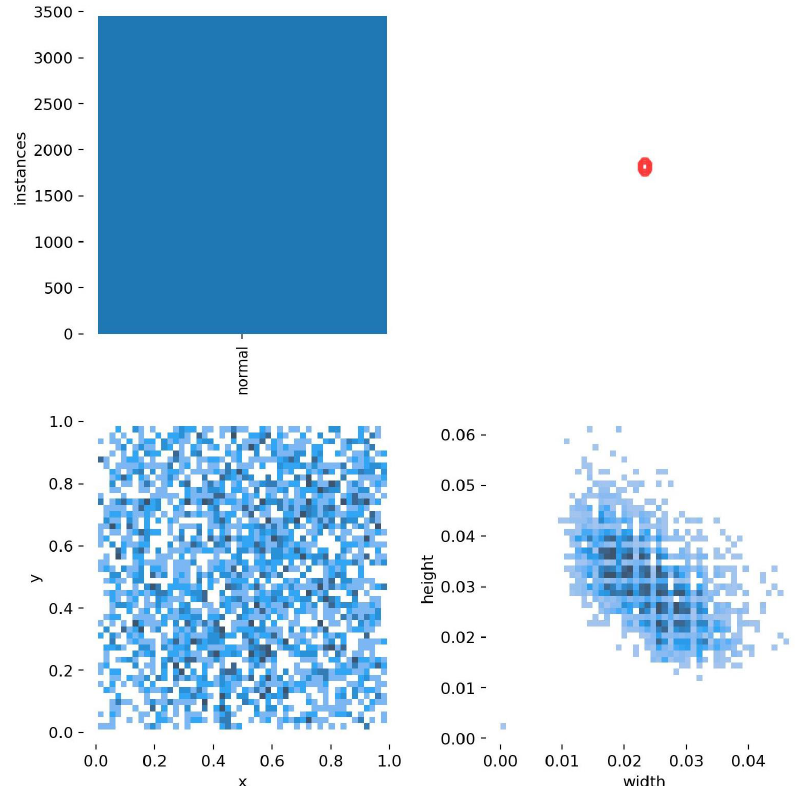
Figure 4. Explained labels and their sizes as width and height of boxes. Plotted with seaborn package.